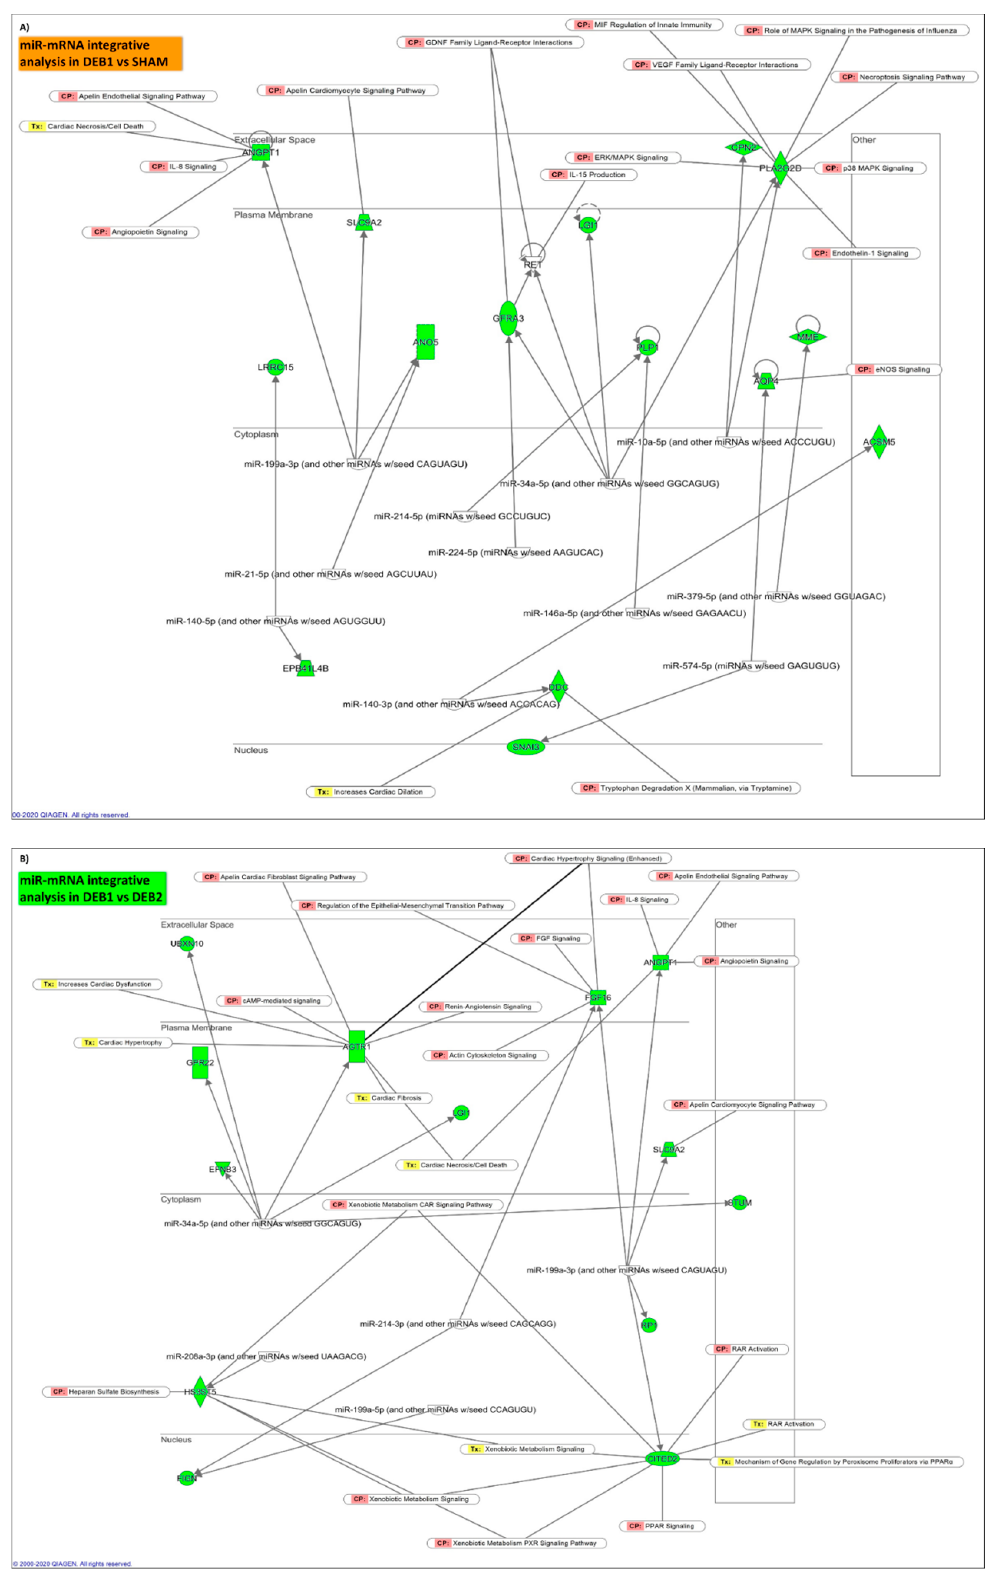
Figure 5. Integrative analysis connections between top down-regulated mRNA (in green) and the top-upregulated miRs in DEB1 when compared with SHAM ( A ) and with DEB2 ( B ). The molecules are distributed accordingly to their subcellular location. Analysis performed using Ingenuity pathway analysis software, Qiagen. CP, Canonical Pathway; Tx, Ingenuity Toxic List.